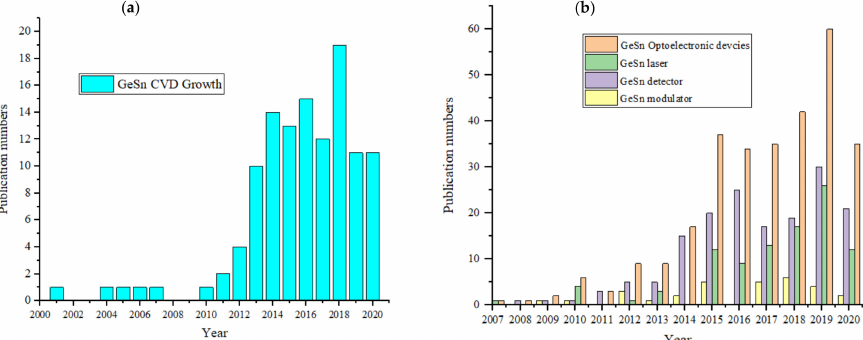
Figure 5. ( a ) Number of publications/year on GeSn materials grown by the CVD technique; ( b ) num- ber of the publications/year on GeSn optoelectronic devices (theoretical calculations and conference proceedings are